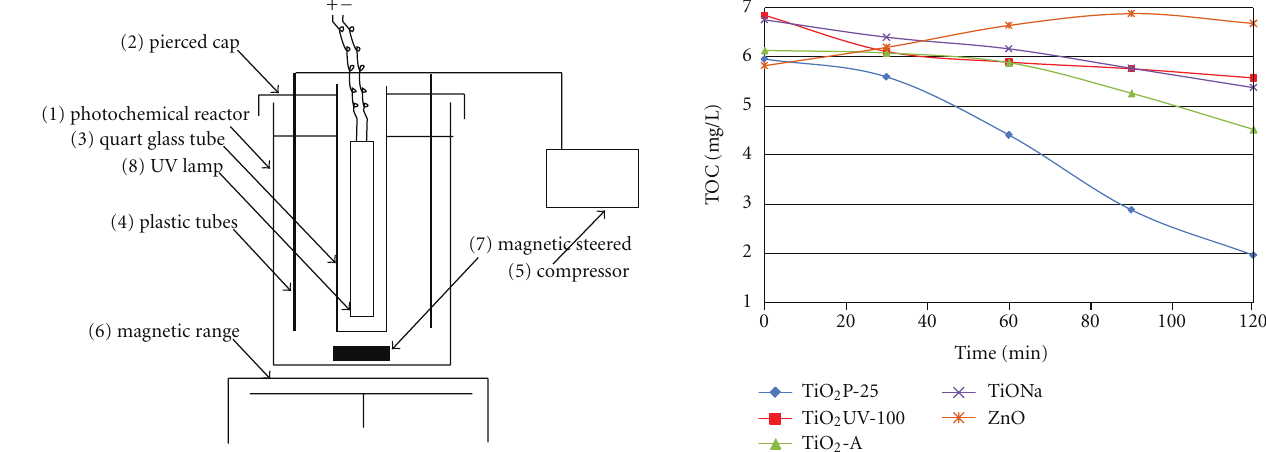
Figure 3: Pesticide degradation by heterogeneous photocatalysis using di ff erent catalysts (initial conditions: 10 ppm mepiquat chloride, 0.5g/L catalyst, UV-A lamp).